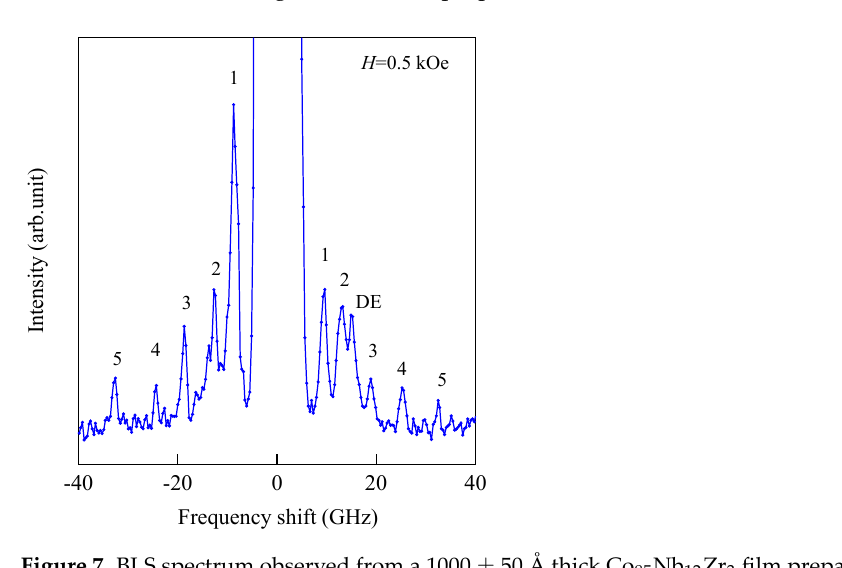
Figure 7. BLS spectrum observed from a 1000 ± 50 Å thick Co 85 Nb 12 Zr 3 film prepared by means of rf‑magnetron sputtering from alloy target onto glass substrate. Labels 1–5: SSW mode number; DE: DE surface mode. (Copyright (1994) The Japan Society of Applied Physics.) [62].